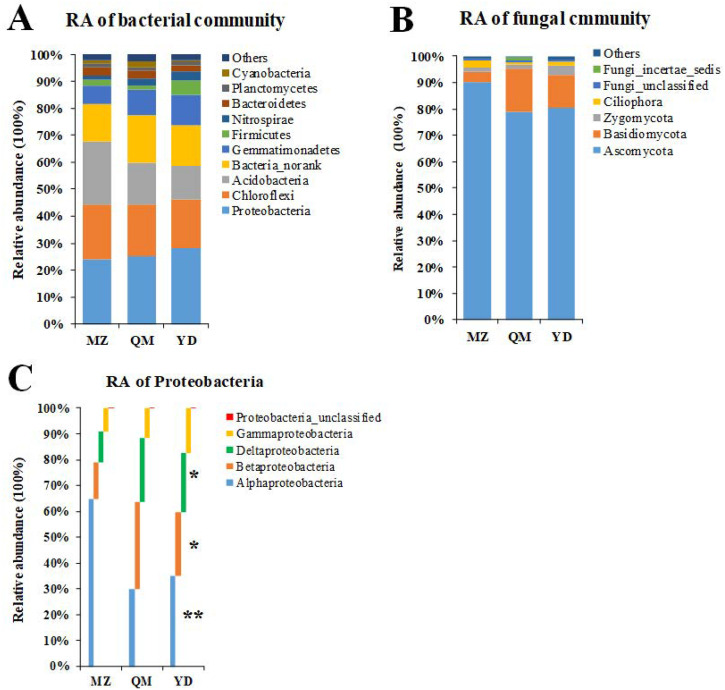
The RA distribution of soil bacterial (A) communities, fungal (B) communities and phyla Proteobacteria community (C) in three different soils.MZ = continuous cropping proso millet for 5 years, YD = continuous cropping common bean for 5 years, QM = continuous cropping common buckwheat for 5 years. RA = relative abundance. * = Significant difference at P <0.05 level, ** = Significant difference at P <0.01 level.